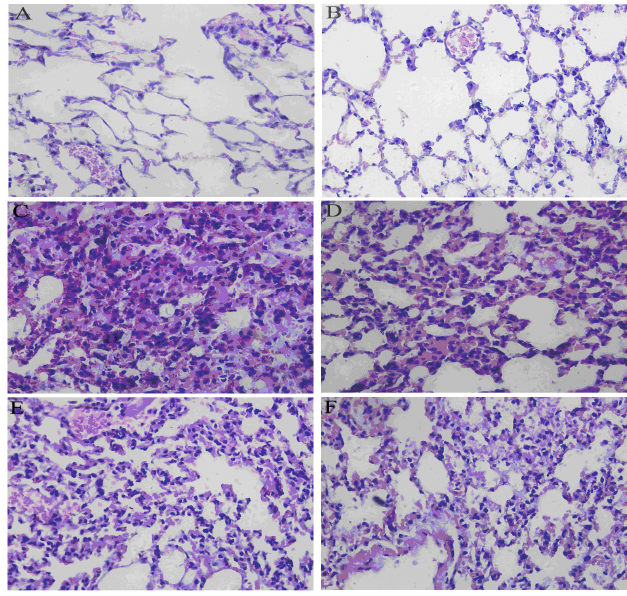
Figure 5. Effects of RA on histopathological changes in lung tissues in LPS-induced ALI mice. ( A ) PBS-challenged mice; ( B ) RA along treated mice (20 mg/kg); ( C )